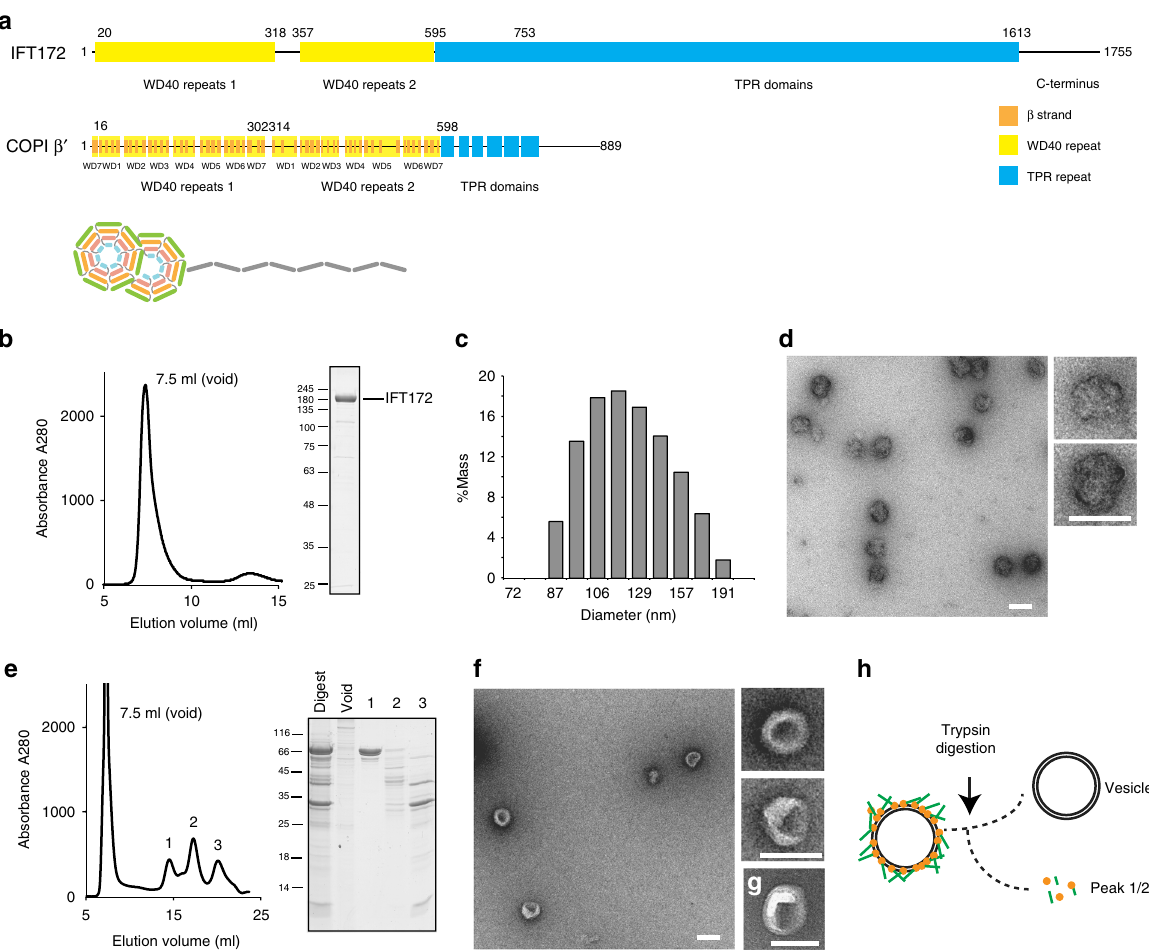
Fig. 1 Characterization of recombinant Chlamydomonas IFT172. a Predicted domain architecture of IFT172 from Chlamydomonas . The predicted WD40 repeats (in yellow) and TPR (tetratricopeptide repeat) domain (in blue) were de fi ned by HHpred. IFT172 shows a similar domain organization to COPI/II and clathrin. COPI β ’ from Saccharomyces cerevisiae is shown for comparison. b Size-exclusion chromatography (SEC) pro fi le of recombinant full-length IFT172 and Coomassie-stained SDS-PAGE analysis of recombinant IFT172 after size-exclusion chromatography. c Dynamic light scattering (DLS) measurement of IFT172 shows a uniform particle size distribution of IFT172 with an average diameter of ~120 nm with 100% mass. d Negative stain EM micrograph of IFT172 showing globular oligomer formation. Scale bar: 100 nm. e SEC pro fi le of IFT172 proteolyzed products after limited-proteolysis (left) and SDS-PAGE of the peak fractions from SEC (right). f Negative stain EM micrograph of the fraction from the void peak in e shows round particles with smooth surface. Scale bar: 100 nm. g Negative stain EM micrograph of the liposomes from Folch fraction I as a control. Scale bar: 100 nm. h Scheme describing the experimental procedure of e and